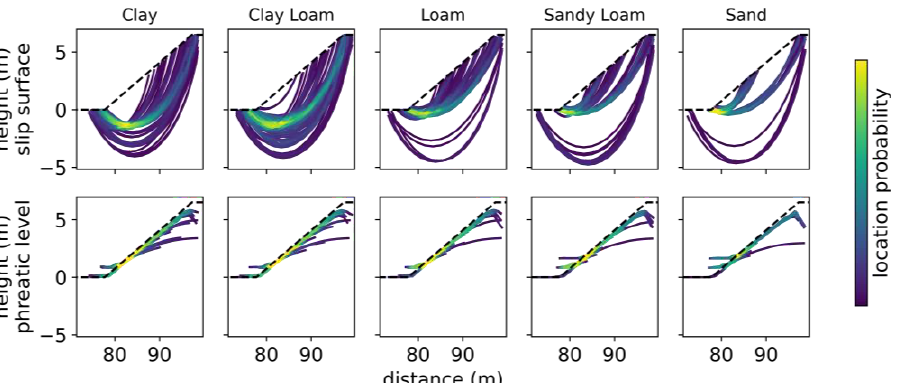
Figure 10. Probability of slip surface location and phreatic surface for different types of upper layer ( 𝑈 𝑡𝑦𝑝 ) material. Brighter colors indicate a larger probability of, respectively, the slip surfaces or phreatic surfaces to occur at that location.